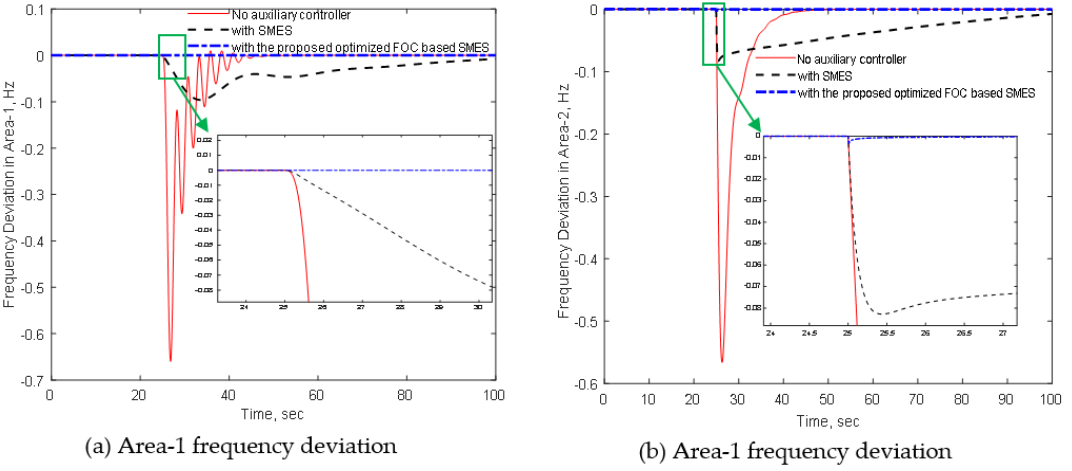
Figure 10. Frequency response for 0.2 p.u. load change in area-2.